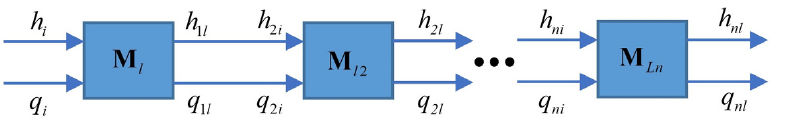
Figure 2. Four-port equivalent model when multiple tubes are connected in series.